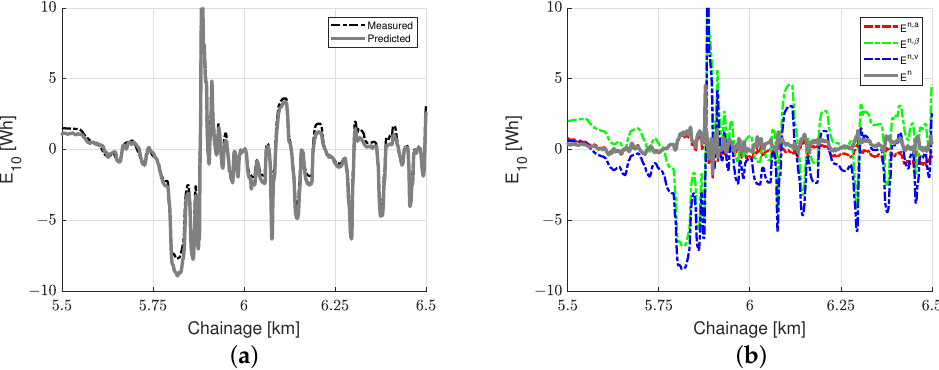
Figure 8. Energy consumption data for a single trip on M3: ( a ) measured versus predicted energy consumption and ( b ) energy